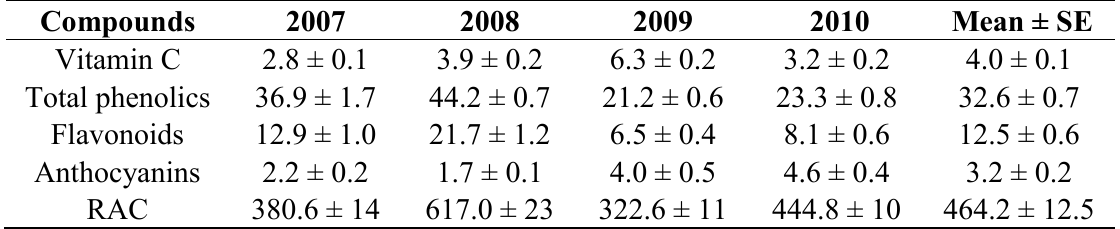
Table 3. Annual amounts of antioxidant compounds in the “Venus” × “Big Top”